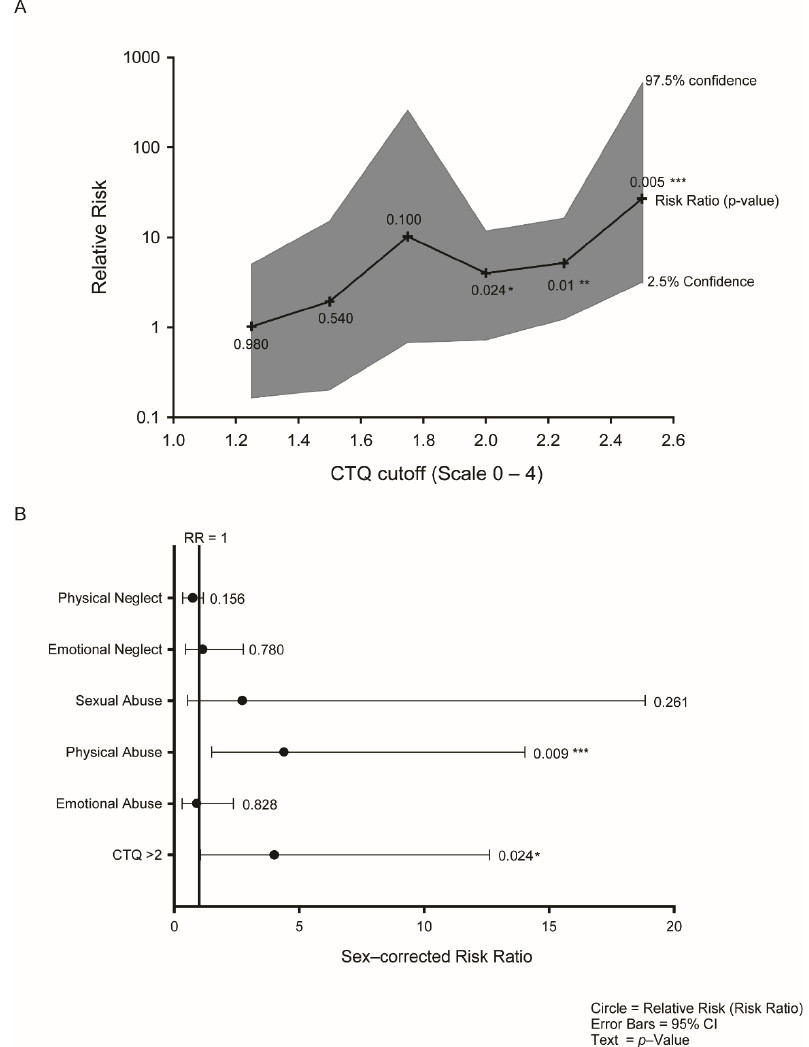
Figure 2. Exposure to early-life adversity is associated with SARS-CoV-2 seropositivity in asymp- tomatic or oligosymptomatic individuals. ( A ) ELA is linked to SARS-CoV-2 seropositivity in a dose-dependent manner as the cutoff for being considered subject to ELA increases. The central black line represents the sex-adjusted logistic regression relative risk (RR); the grey shaded area represents the 95% confidence interval; text: p -value. ( B ) Sex-adjusted logistic regression relative risk of IgA seropositivity for the CTQ subscales identifies physical abuse as a key element of the overall CTQ score contributing to the risk of IgA seropositivity. Circles represent the relative risk (RR); error bars: 95% confidence interval; text: p -value. *, p < 0.05; **, p < 0.01; ***, p <